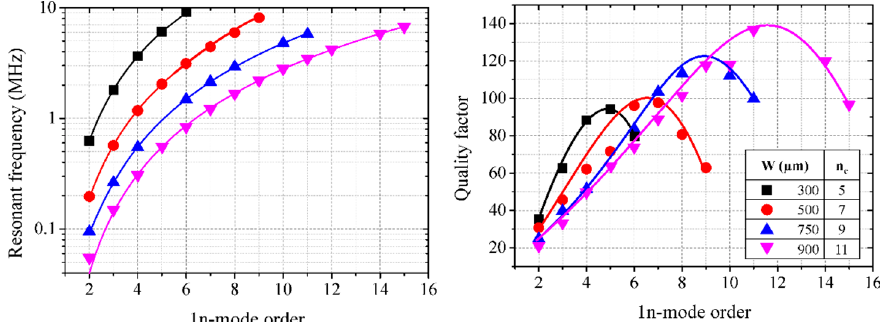
Figure 7. Resonant frequencies and quality factors as a function of order of the roof tile-shaped mode for the 1000 µm long, 10 µm thick cantilevers, deduced from the electrical impedance measurements in isopropanol. The coincidence point ( n c ) is also given for each width.